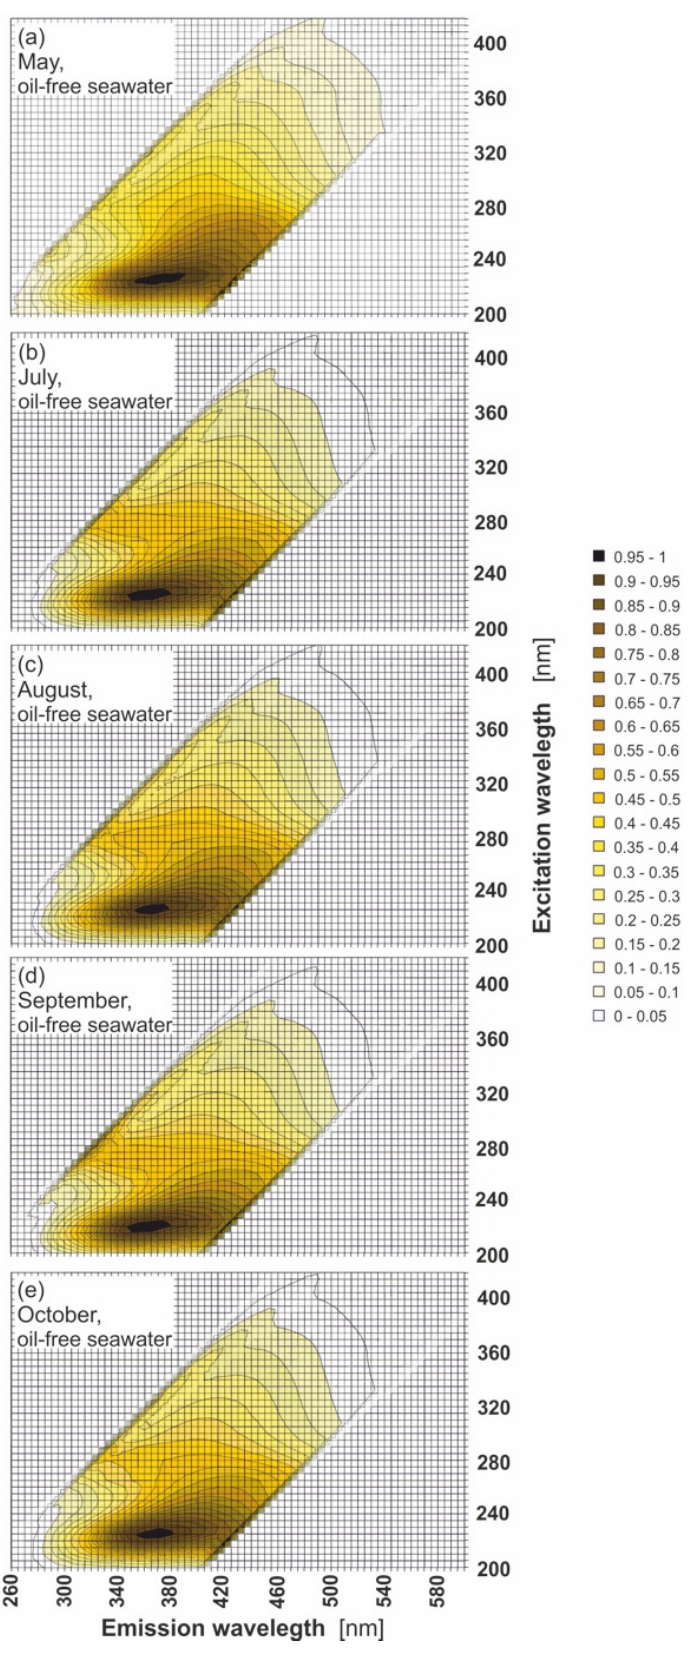
Figure 3. Excitation–emission spectra of oil-free seawater for various months: May ( a ), July ( b ), August ( c ), September ( d ), and October ( e ) in 2019.